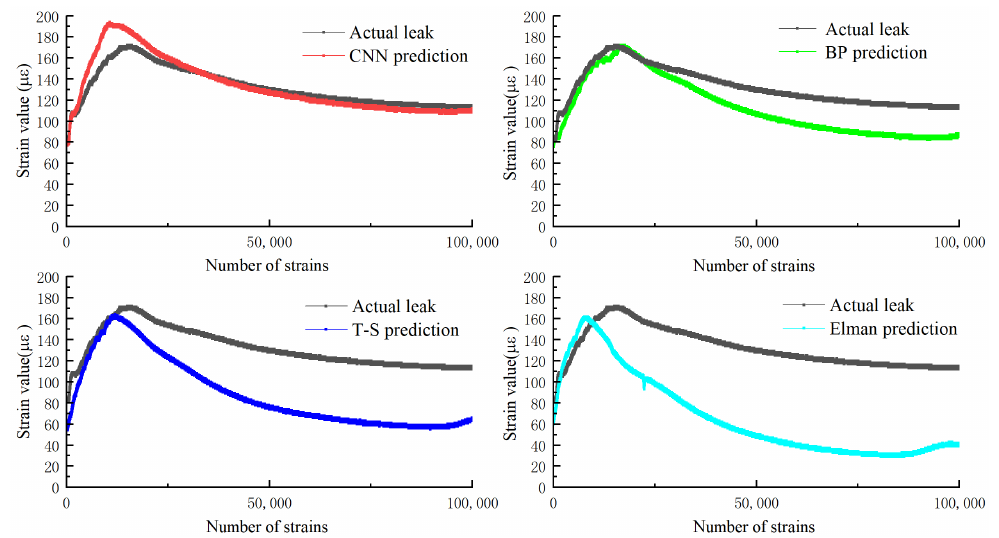
Figure 11. Four kinds of neural network simulation